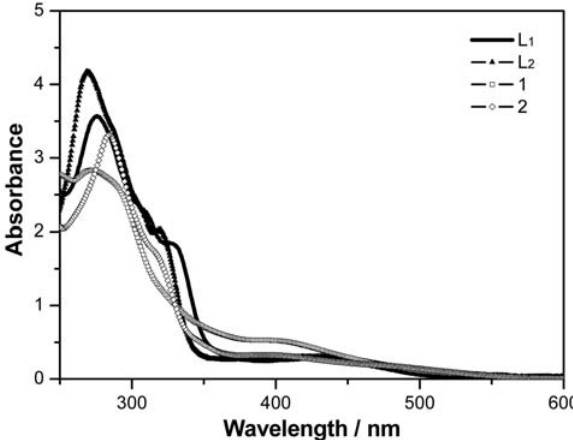
Fig. 1. Electronic absorption spectra of ligands L xes 1 – 2 in CH